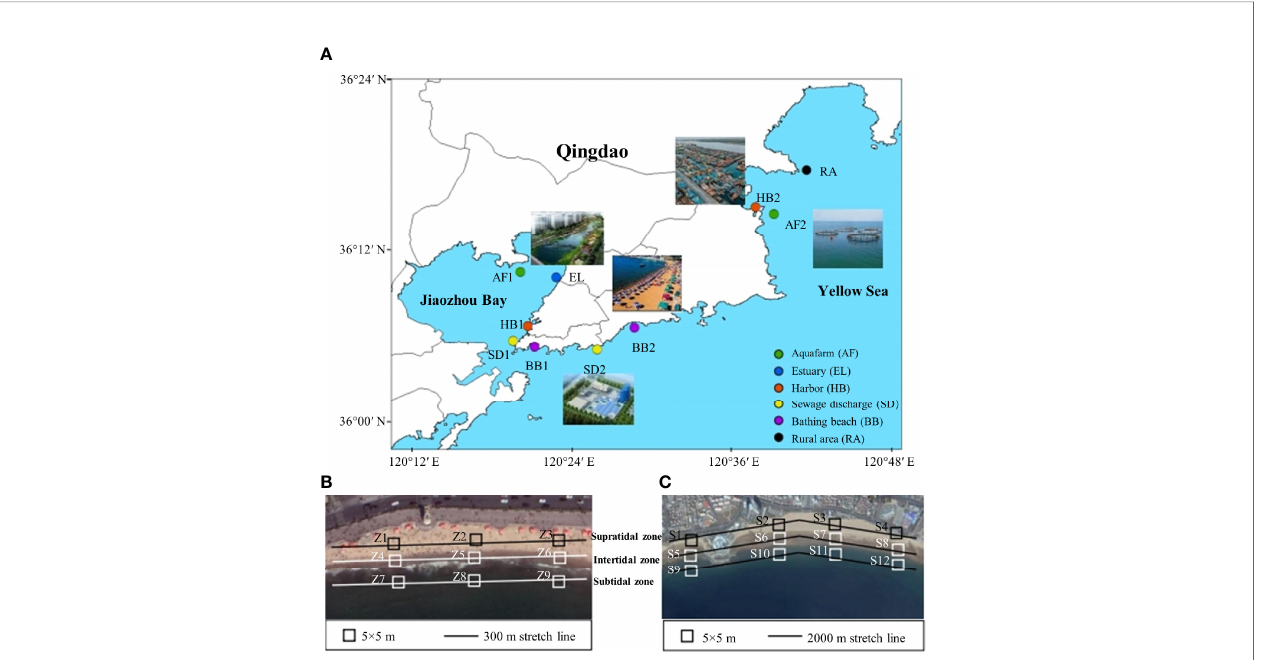
FIGURE 1 | The sampling zones along the coastal Qingdao (A) and their detailed information was provided in Table S1 . Sampling sites within the scenic beach (BB1, B ) and recreational beach (BB2, C ). Site Z1 – Z3 and S1 – S4 were selected in the supratidal zone. Sites Z4 – Z6, S5 – S8 were selected in the intertidal zone, and sites Z7 – Z9, S9 – S12 were selected in the subtidal tidal. Sites S1, S5, and S9 were selected within the business and leisure areas. Sites S2, S6, and S10 were located close to the sewage outlet. Sites S3, S7, and S11 were located in the areas of bathing, and sites S4, S8, and S12 were located in undeveloped area. The fi ve – point method was used for sampling sand samples from the beaches, and each sampling area was 5 × 5 m. The solid line in the panel (B) represents 300 m stretch line in the scenic beach, and the solid line in the panel (C) represents 2000 m stretch line the scenic